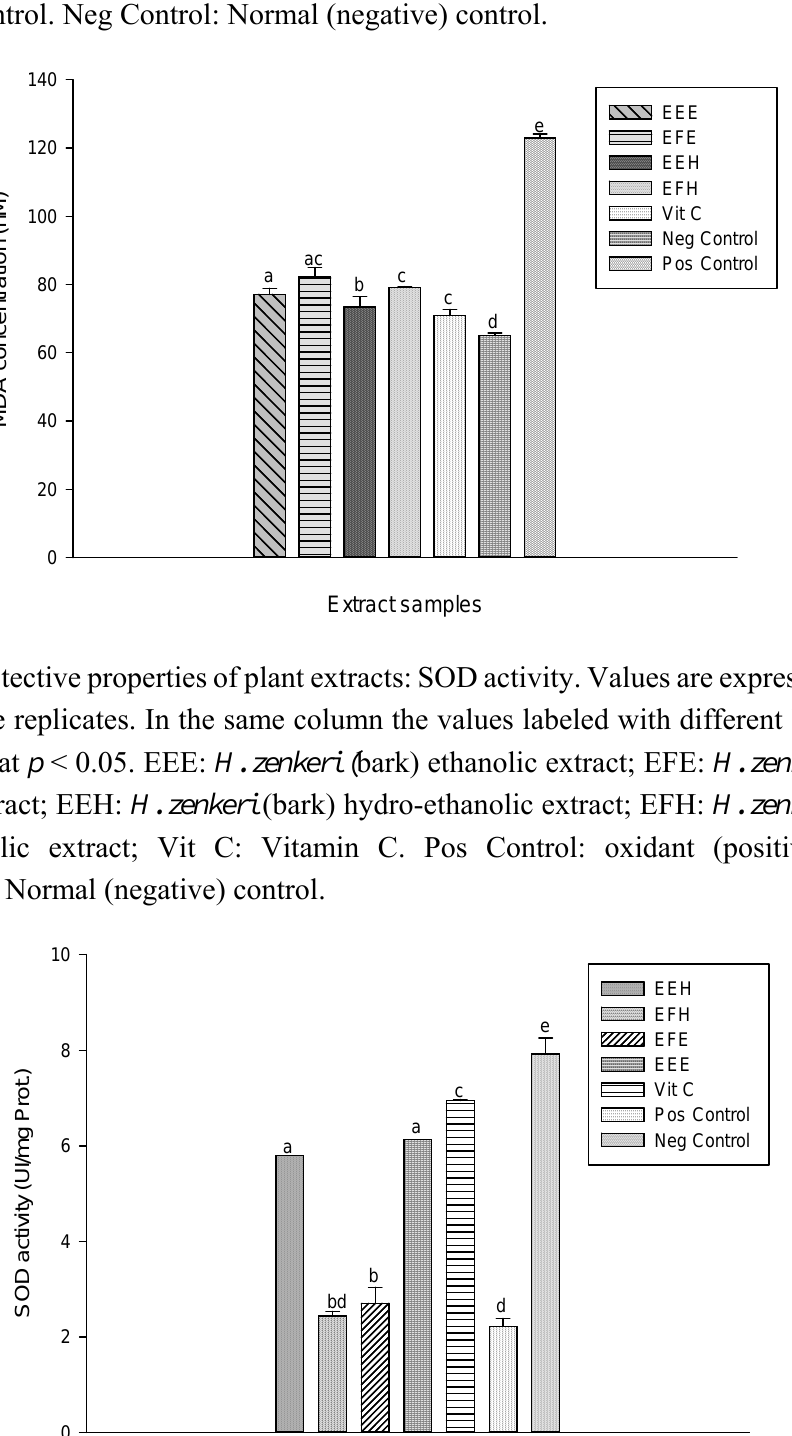
Figure 8. Protective properties of plant extracts against lipid peroxidation. Values are expressed as mean ± SD of three replicates. In the same column the values labeled with different letters differ significantly at p < 0.05. EEE: H. zenkeri ( bark) ethanolic extract; EFE: H. zenkeri (leaves) ethanolic extract; EEH: H. zenkeri (bark) hydro-ethanolic extract; EFH: H. zenkeri (leaves) hydro-ethanolic extract; Vit C: Vitamin C. Pos Control: oxidant (positive) control. Neg Control: Normal (negative) control.